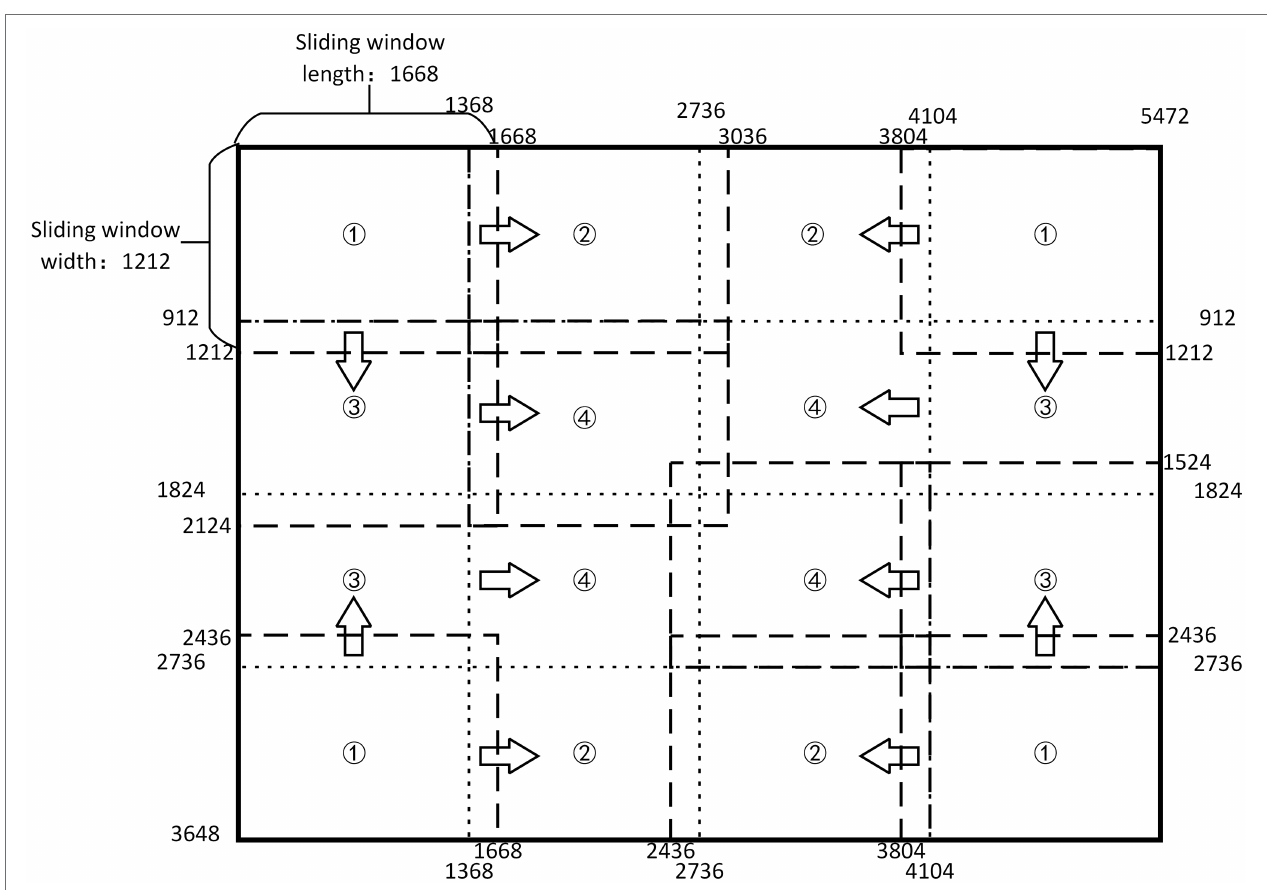
FIGURE 3 | The diagram of overlapping sliding window